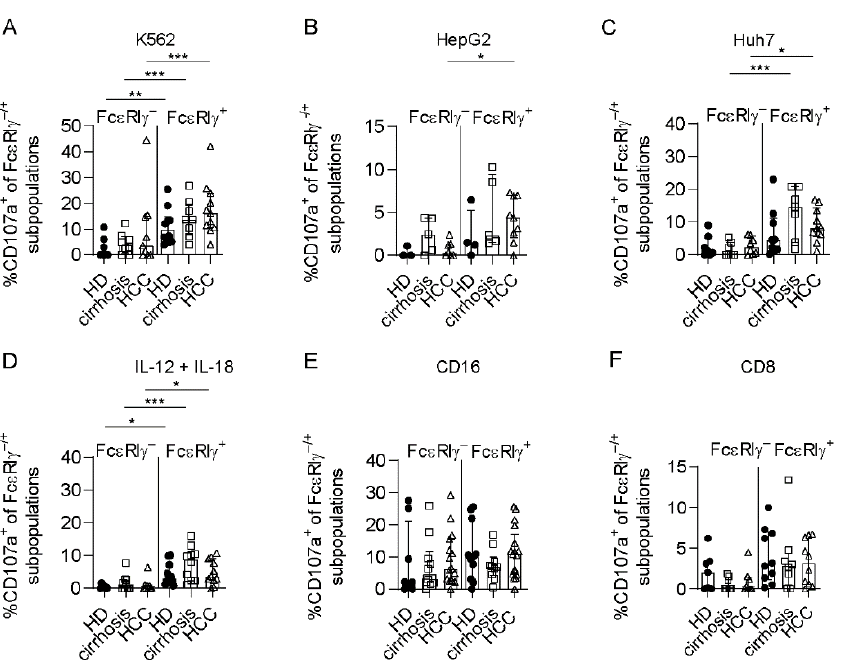
Figure 5. Conserved functionality of CD56 dim NK-cell subpopulations. CD107a expression of Fc ε RI γ -subpopulations in HCC patients, HD and patients with liver cirrhosis after stimulation with K562 ( A ), (HCC Fc ε RI γ − n = 9, HCC Fc ε RI γ + n = 11, HD Fc ε RI γ − n = 7, HD Fc ε RI γ + n = 10,